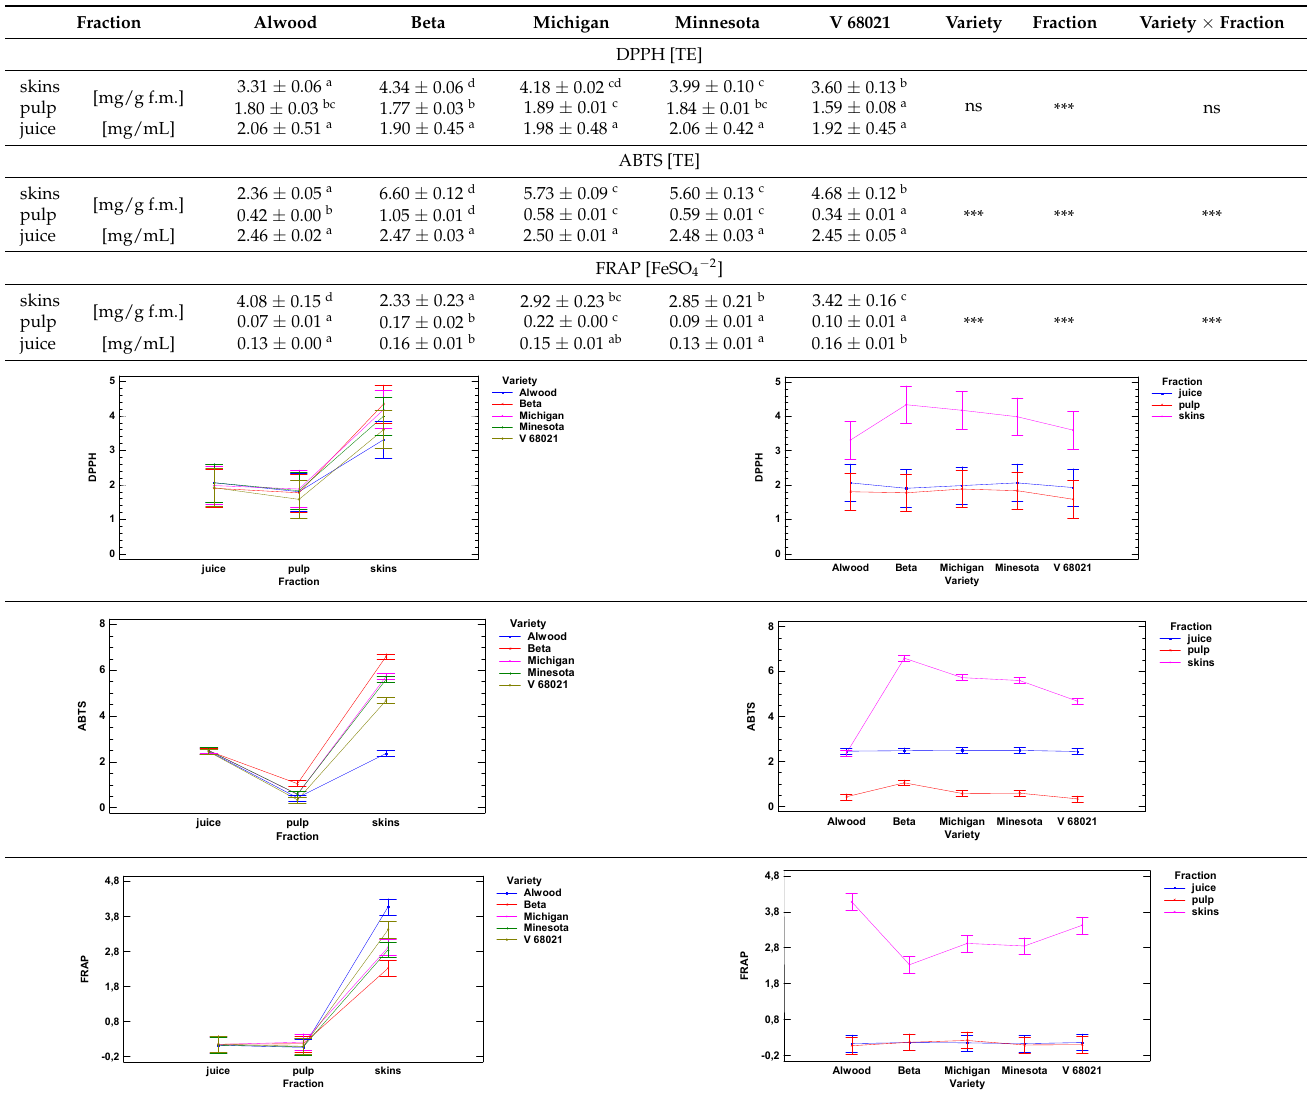
Table 2. Antioxidant activity and oxidoreductive potential of the fruits of 5 Vitis hybrid grape cul- tivars grown in the Rzeszów foothills (in the Lower San Valley) in Poland.